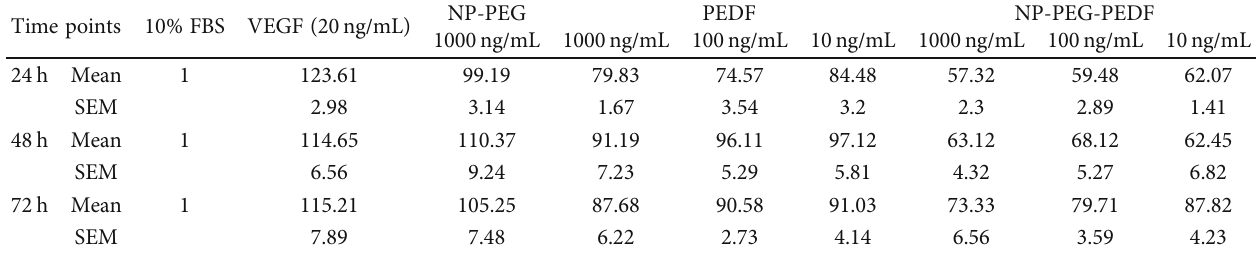
Table 2: Summary of proliferation e ff ects of PEDF and NP-PEG-PEDF combined with VEGF-treated HUVECS under high glucose (30 mmol/L).